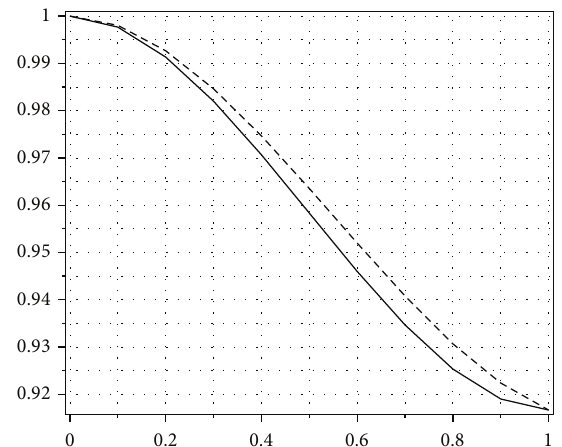
Figure 4: Comparison between exact and approximate solutions of Example 4 for 𝑘 = 0 . Solid line represents exact solution and dash line represents approximate solution.